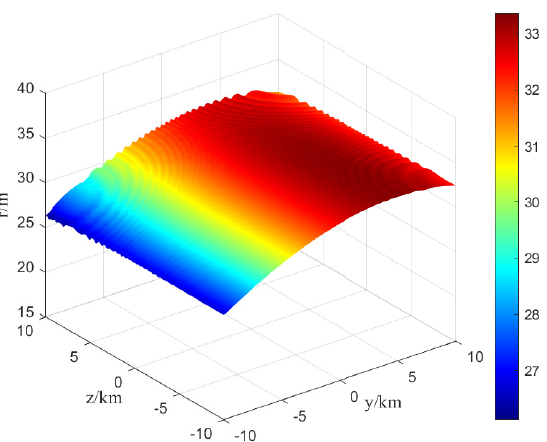
Figure 13. The curved surface of the miss distance and 10,000 different initial